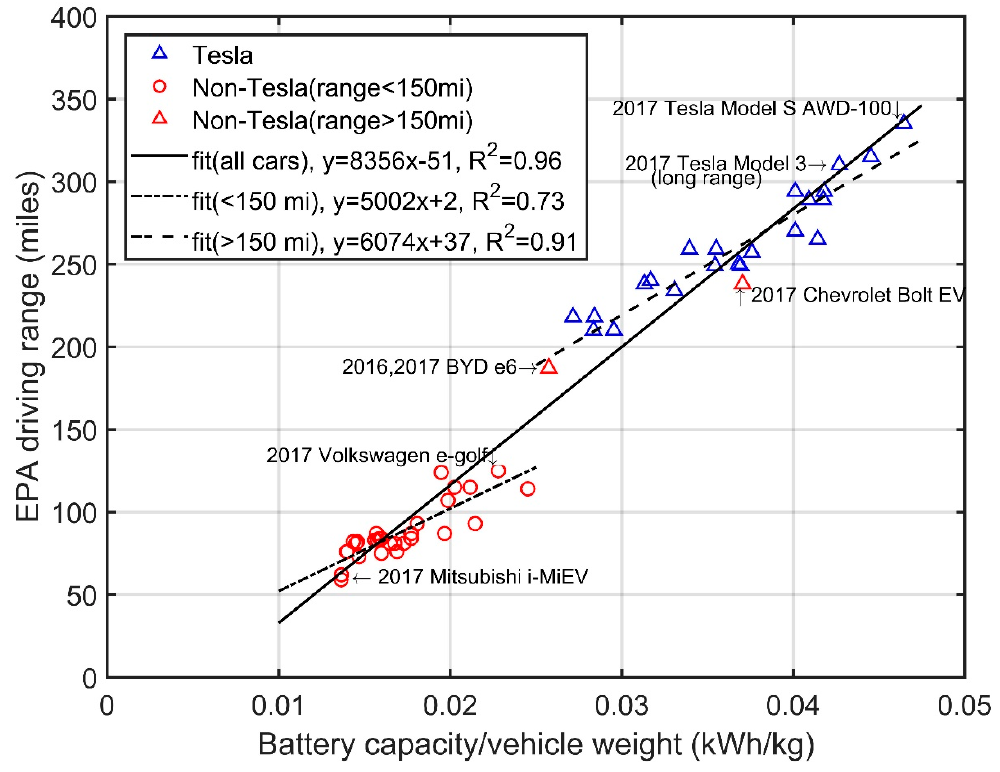
Figure 1. Scaling trend of EPA driving range (miles) per charge vs. battery capacity/vehicle curb weight (kWh/kg). Blue represents Tesla vehicles, red represents non-Tesla vehicles, circle represents short-range BEVs, and triangle represents long-range BEVs.